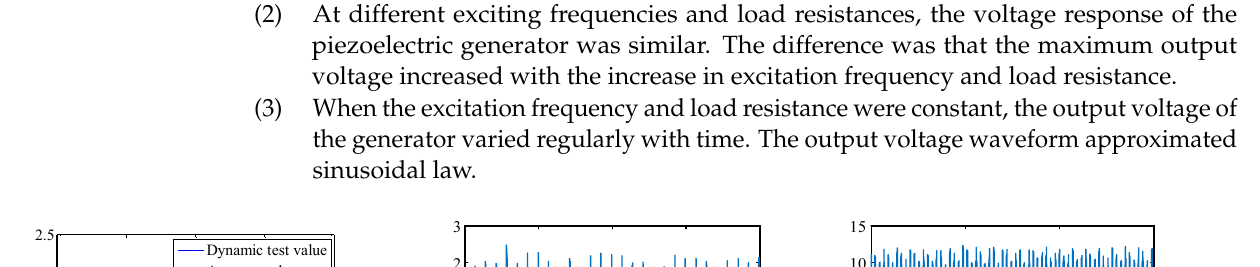
( c ) Figure 10. Instantaneous voltage and power of the proposed piezoelectric generator. ( a ) Instanta- neous voltage at R = 10 K Ω ; ( b ) instantaneous voltage at R = 40 K Ω ; ( c ) instantaneous power. The voltage response of the piezoelectric generator under continuous excitation was also tested. Using a laser displacement sensor with a range of ±5 mm, the vibration am-